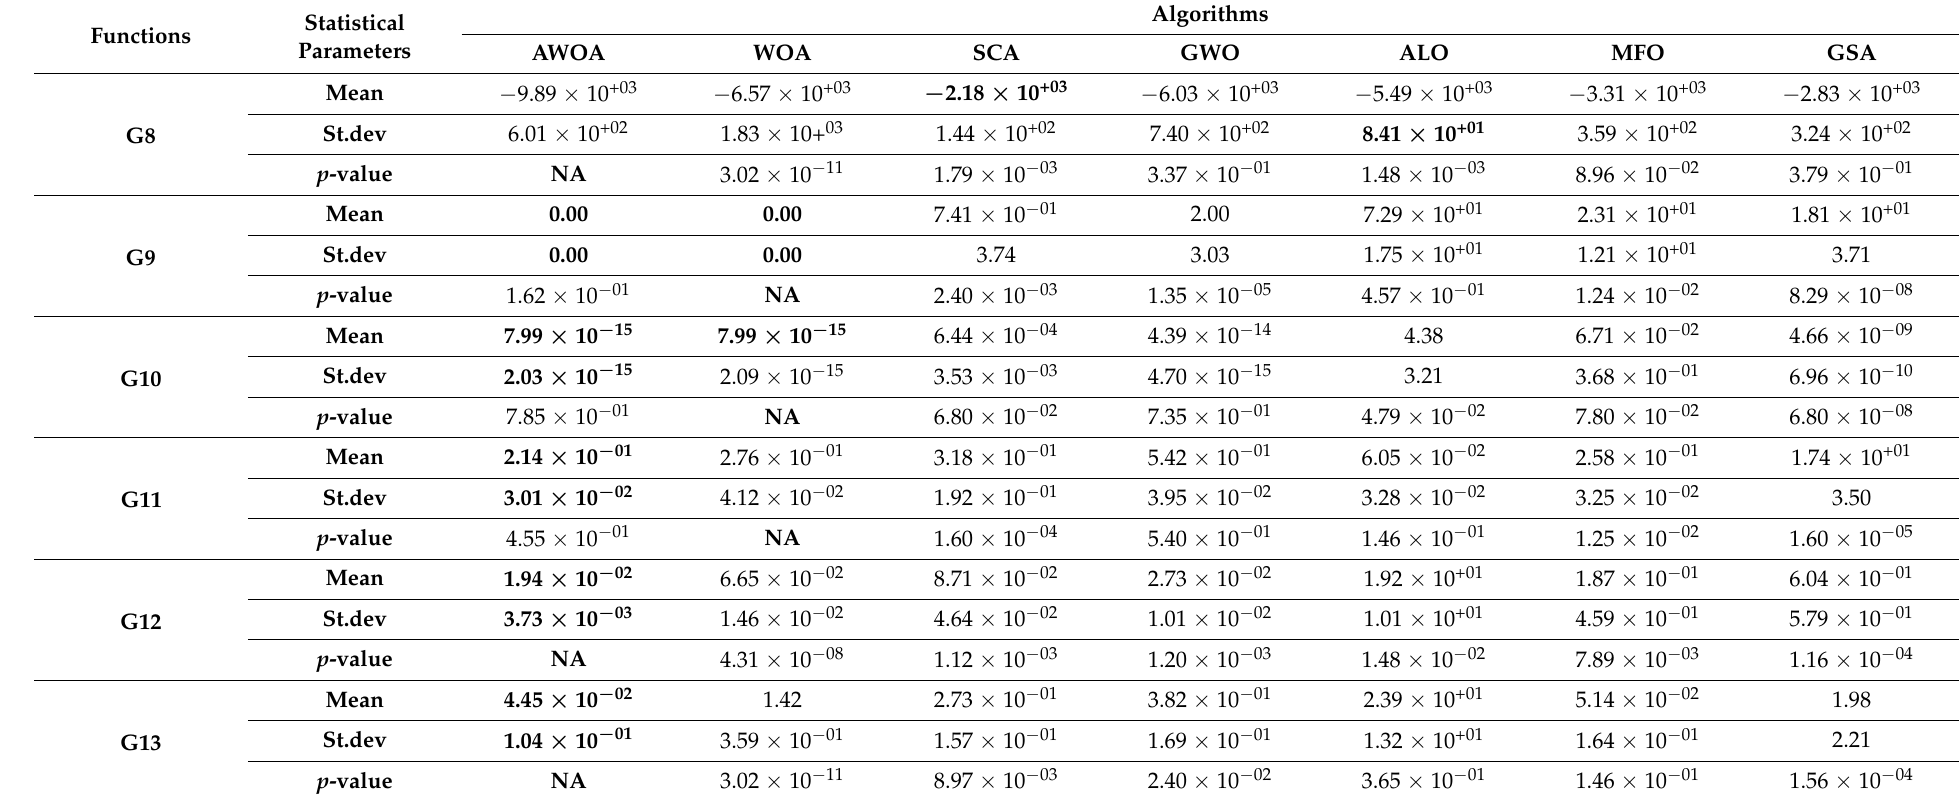
Table 6. Average, Standard Deviation, and p -Value of AWOA and other comparable algorithms for Multimodal